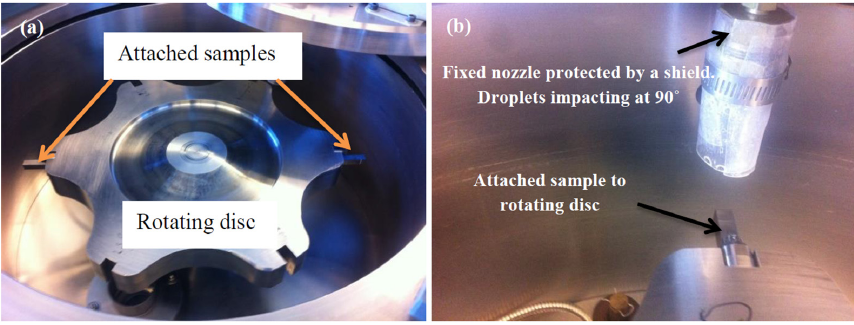
Figure 4. Water erosion rig with attached samples ( a ) and fixed nozzles and sample ( b ).